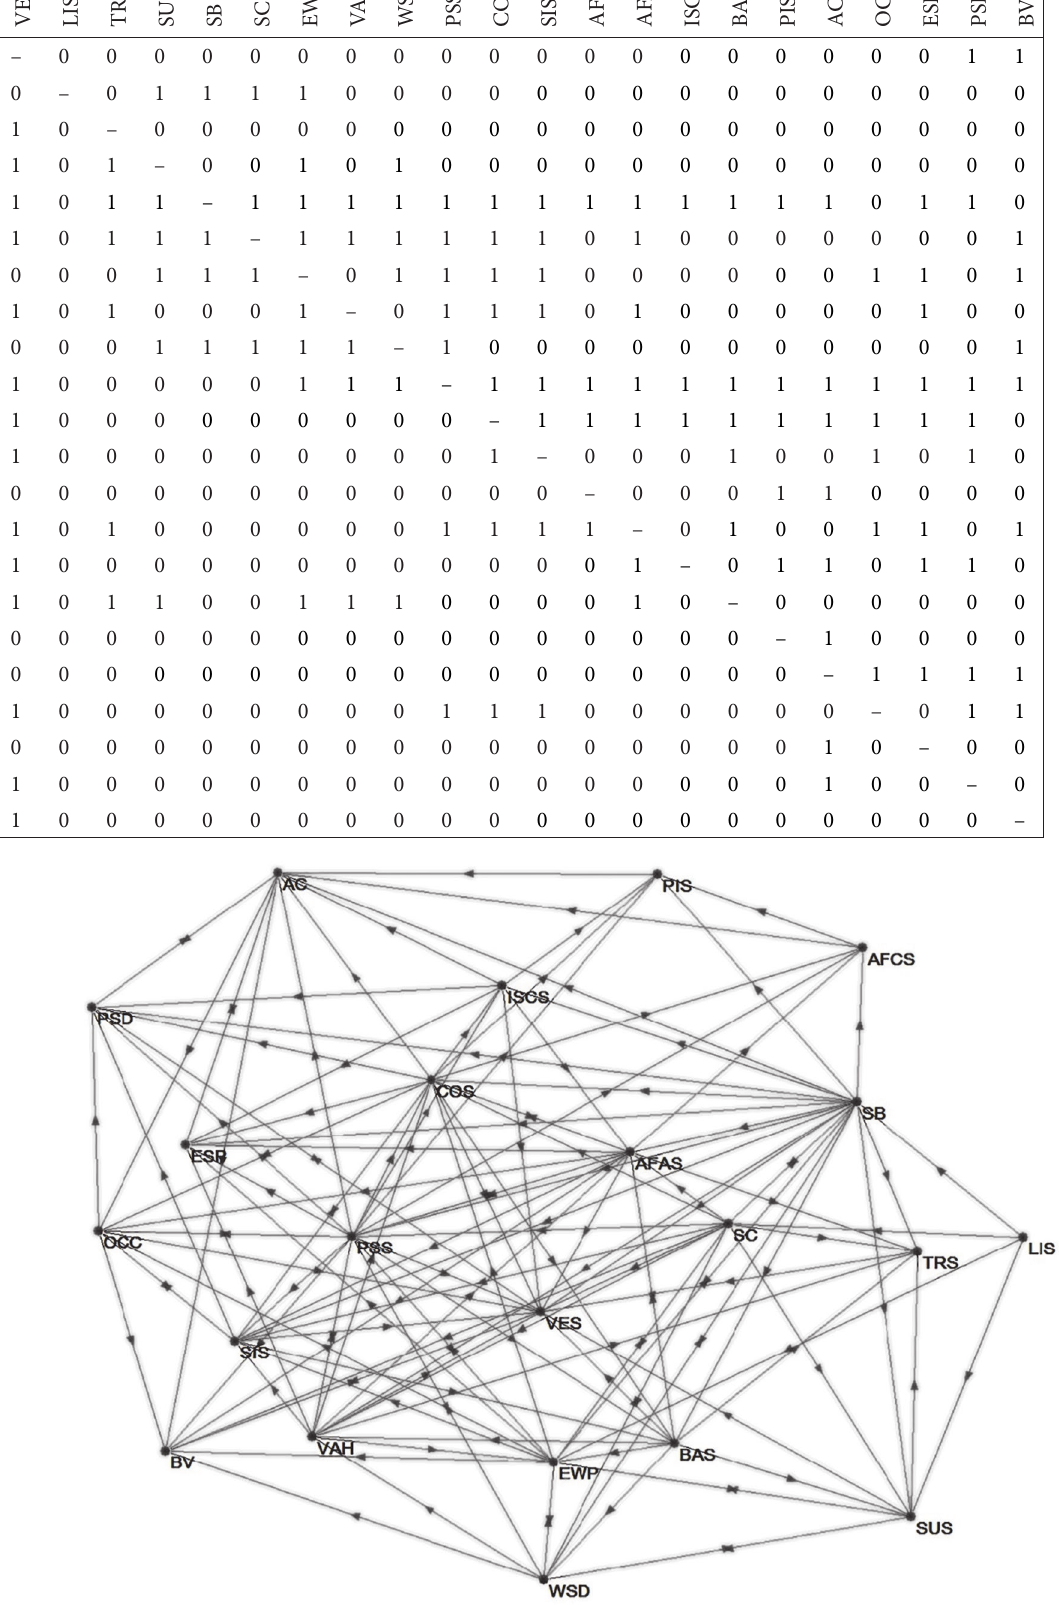
Figure 9. The topology of SPSN in safety